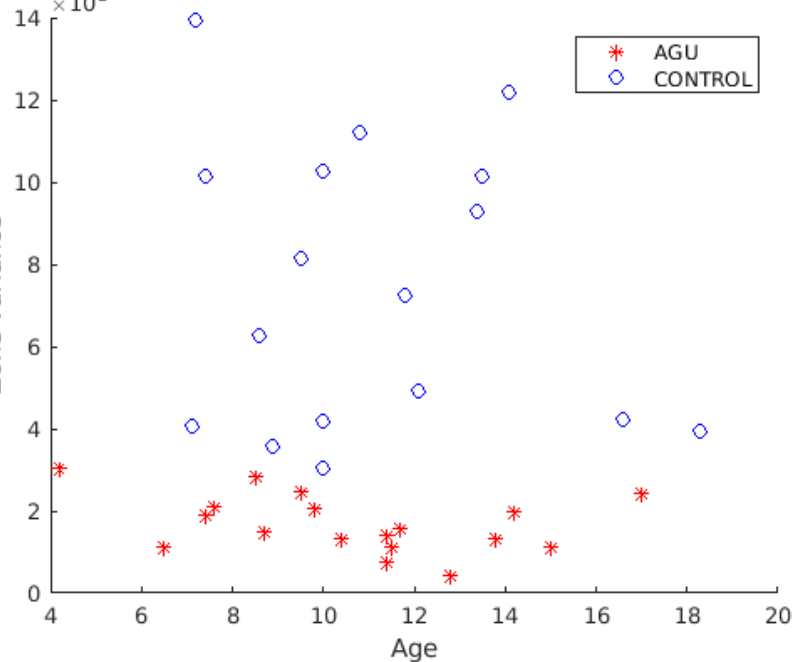
Figure 5. Zone variance calculated from the SWI, plotted against the sum of the thalamic nucleic volumes. Patient and control groups are separated in both x- and y-axes. Zone variance is on par with the thalamus volume as a classification feature.